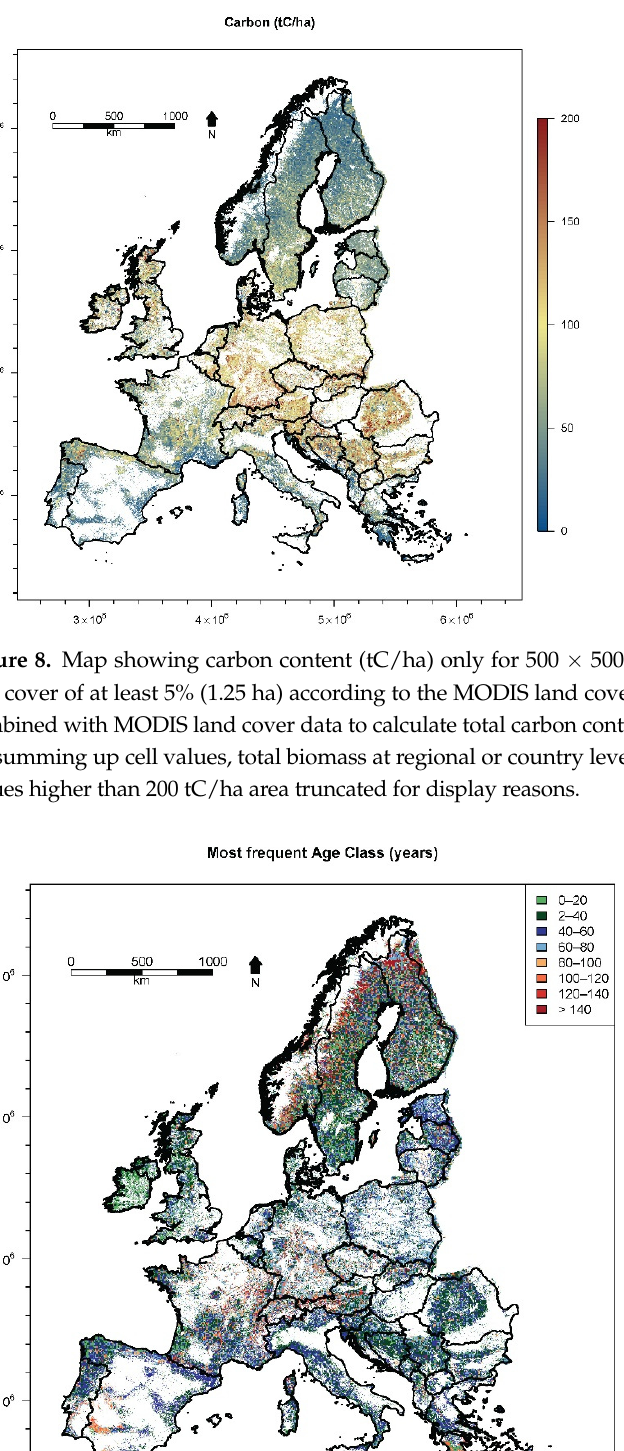
Figure 7. Tree Volume (m 3 /ha) only for 500 × 500 m cells with a minimum tree cover of at least 5% (1.25 ha) according to the MODIS land cover classification. We combined this map with MODIS land cover data to calculate total volume (m 3 ) for each 500 × 500 m cell. Summing up cell values, total volume at regional or country level are estimated. In this figure, values higher than 400 m 3 /ha are truncated for display reasons.